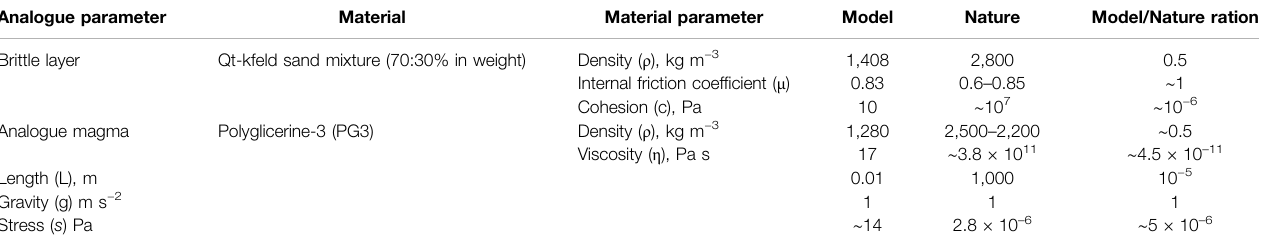
TABLE 2 | Summary of material and scaling parameters.